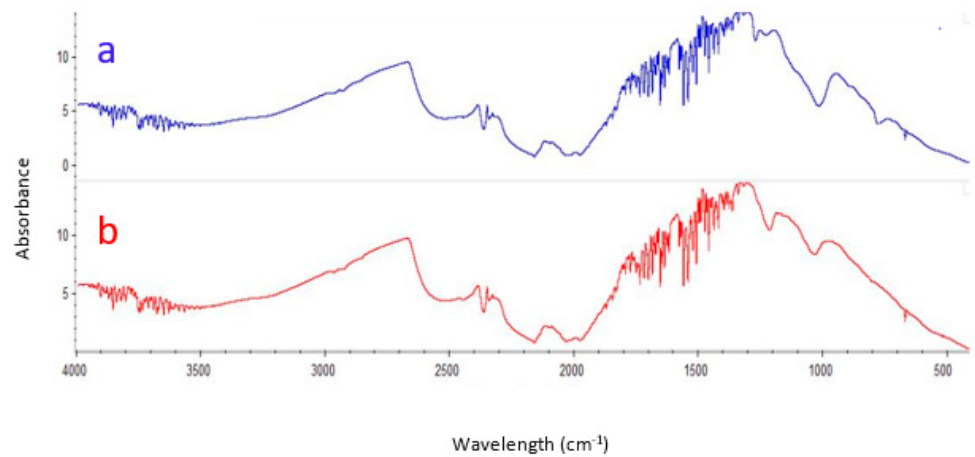
Figure 5. AT-Infra Red spectra of ( a ) functionalised cigarette filters and ( b ) unfunctionalized cigarette filters.